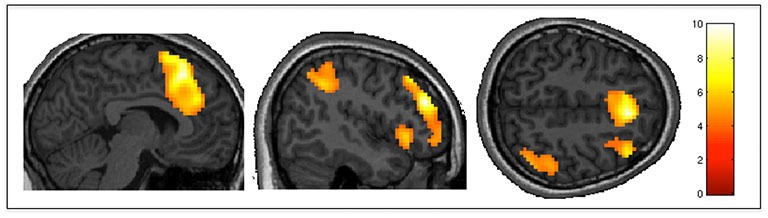
Action selection vs. command following. AS (participants selected their movements), as compared to CF (movements were determined by experimenters) elicited greater activity in the middle frontal gyrus, pre-SMA, somatosensory association cortex and insula. Results are thresholded at FWE-corrected p < 0.05 for cluster level activation, and overlaid on an anatomical T1-weighted image.